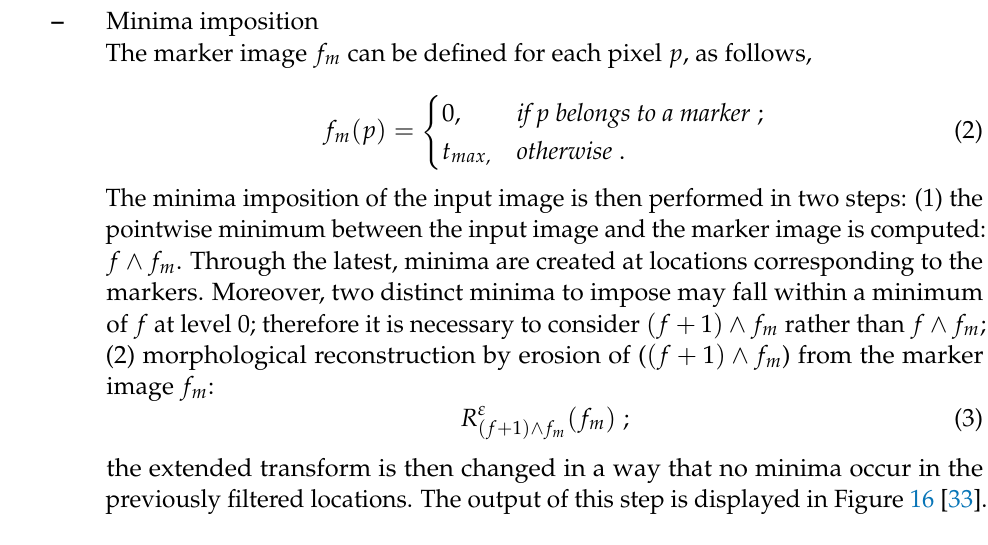
Figure 15. Extended-Minimum Transform, assigning small dots to each “true”